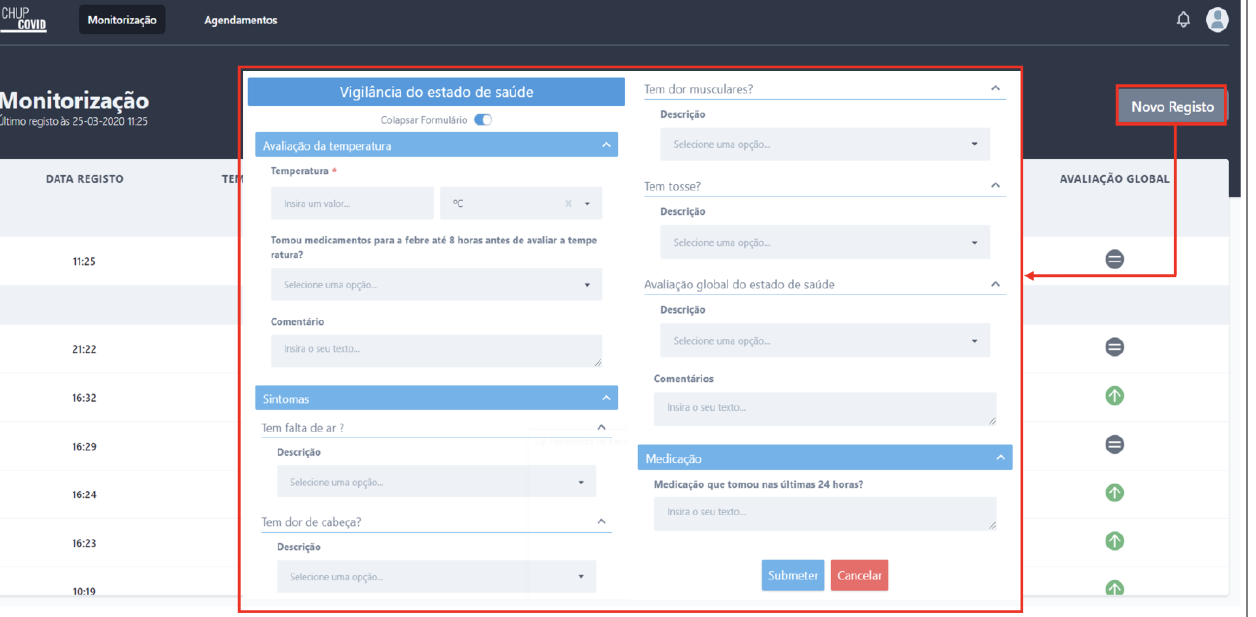
Figure 5. CHUP Monit new form submission to interact with health professionals.